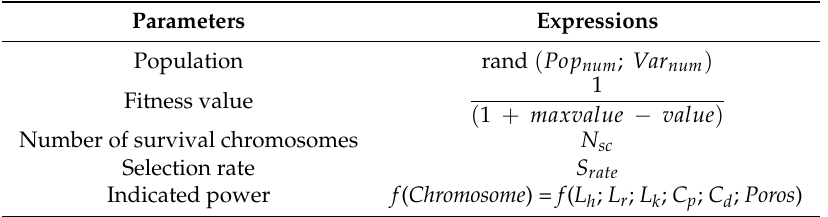
Table 2. Genetic algorithm procedure and